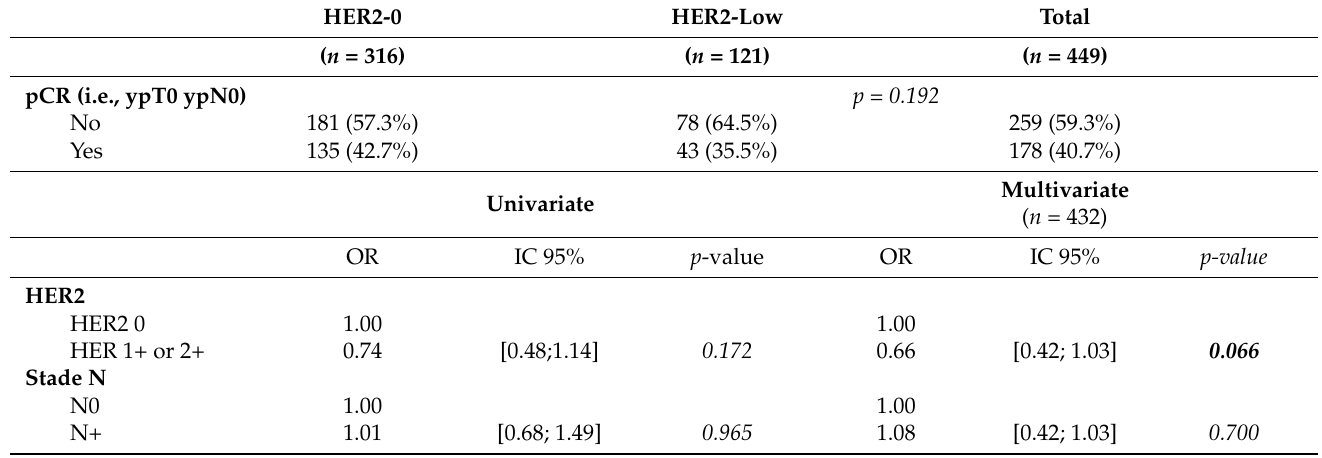
Table 2. pCR according to HER2 status (HER2-low versus HER2-0); univariate and multivariate analysis according to HER2